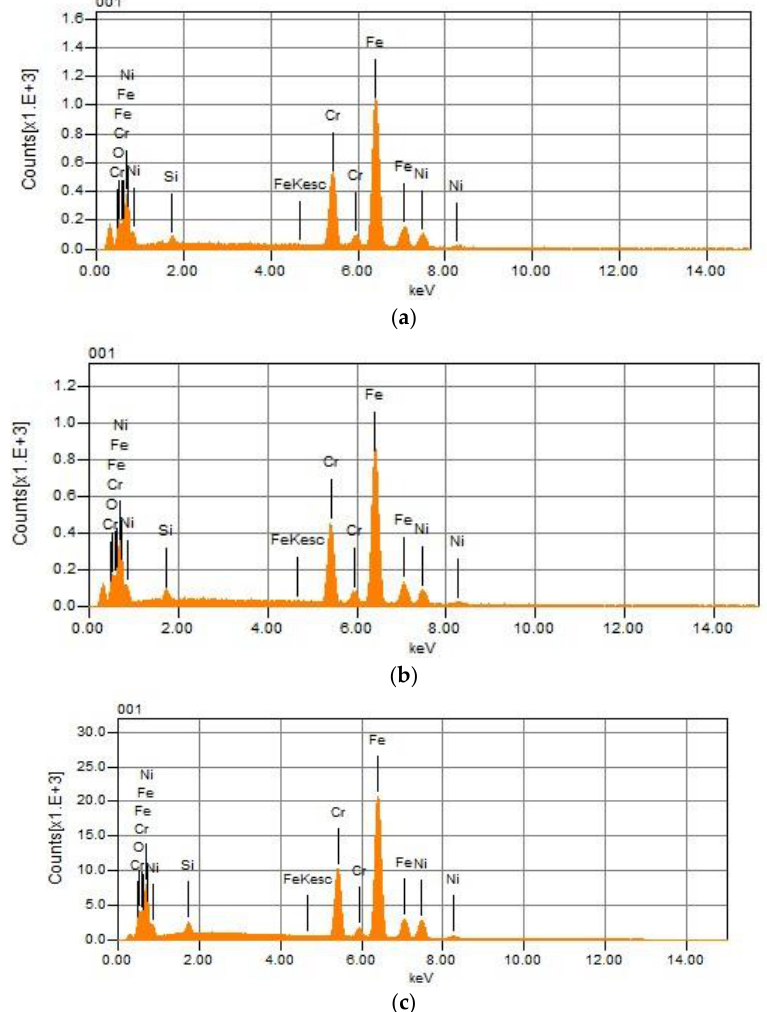
Figure 7. EDS analysis of the ( a ) irregular feedstock, and products after the plasma spheroidisation from the ( b ) catch-pot and ( c ) reactor walls. Table 4. The elemental composition, in wt.%, of the steel and foreign objects detected in the reactor walls.